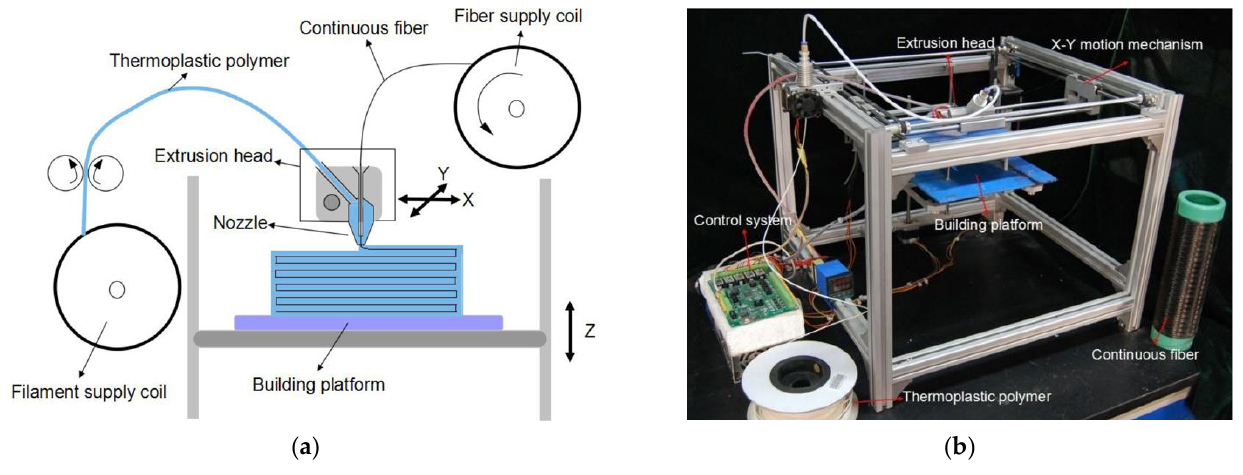
Figure 16. Printing composites by method 2 (M2): embedding in the nozzle. FMD 3D printing process using continuous filament with a printing head of a single nozzle ( a ) schematic diagram ( b ) actual experimental setup Reprinted with permission from [86], 2017, Emerald Publishing, Bingley, UK.